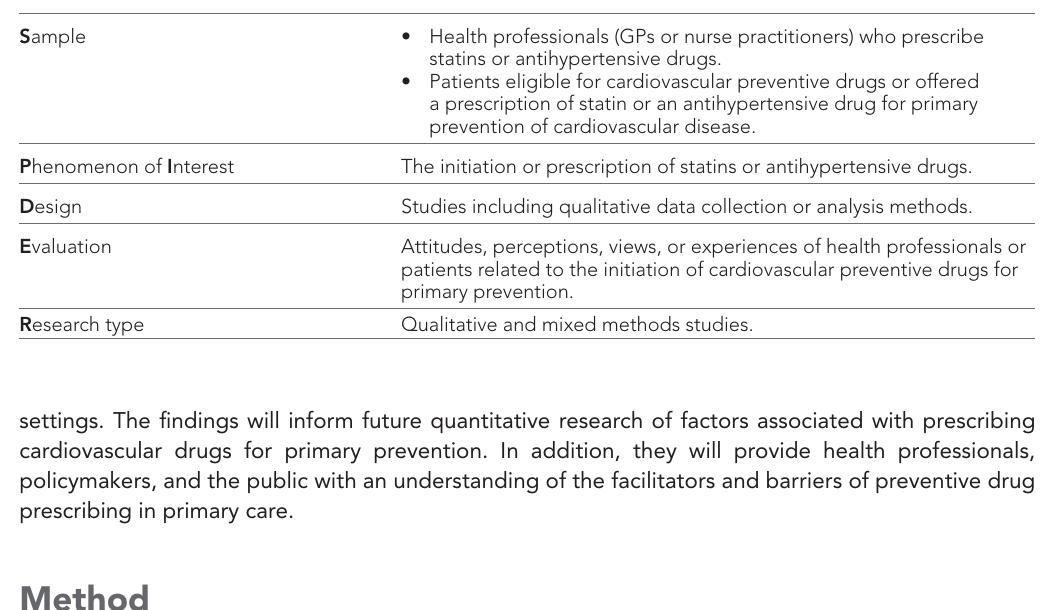
Table 1 Summary of Sample, Phenomenon of Interest, Design, Evaluation, Research (SPIDER) frame-